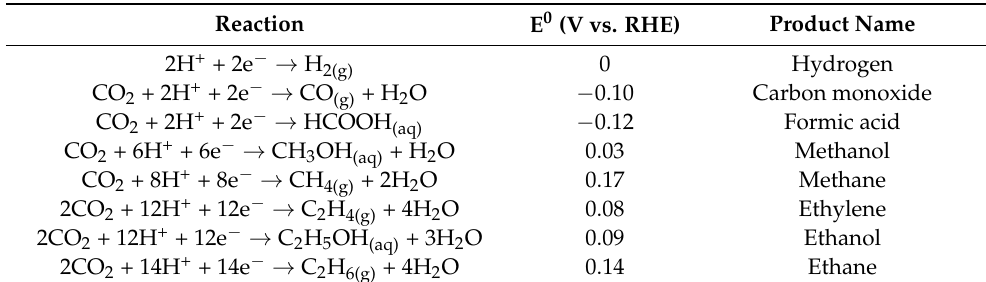
Table 1. Electrocatalytic CO 2 reduction reactions with equilibrium potentials in aqueous solution. Adapted from Ref. [35]. Copyright 2019, American Chemical Society.